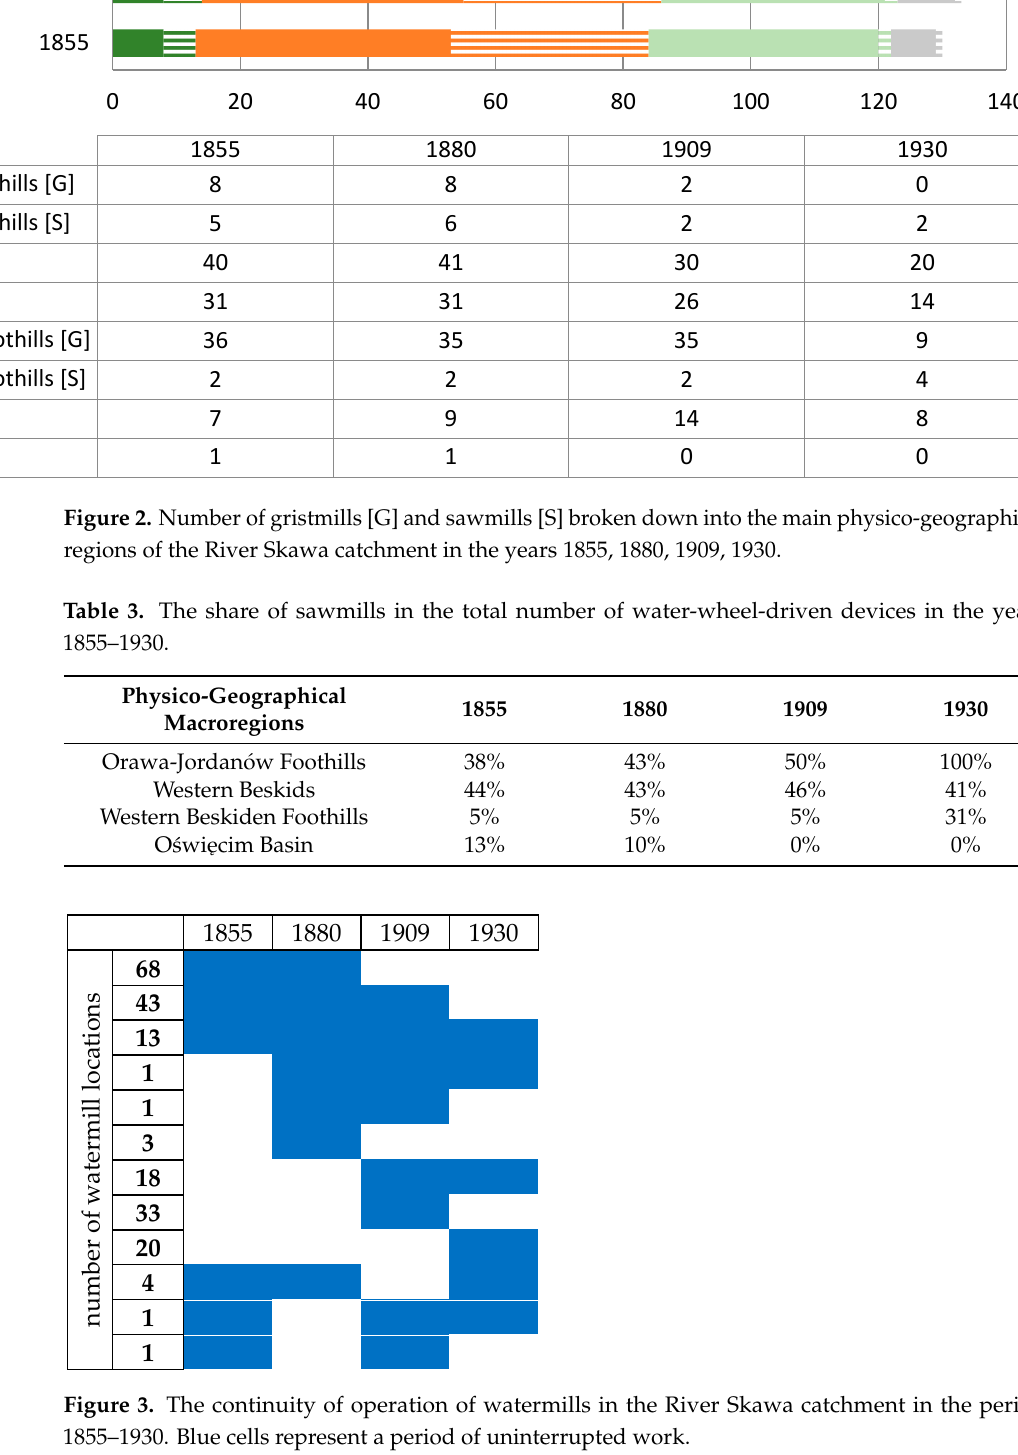
Figure 4. Water source for the watermills in the River Skawa catchment area, broken down into main physico-geographical regions. Only one watermill was located directly over the River Skawa channel in the entire period under study. However, seven weirs were built in the natural channel of the River Skawa, which directed part of the river’s flow to artificial millraces. Two of them were built in the Orawa-Jordanów Foothills, four in the Beskid Mountains, and one in the Western Beskidian Foothills. Millraces in the Beskid Mountains and in the Western Beskidian Foothills made it possible to use the waters of the River Skawa to drive wa- termills in the sections of the valley where the River Skawa channel was braiding or anabranching. In the entire analyzed period, the average power of a watermill decreased along with the downstream movement of the catchment area (Table 4). This is typical of mountain catchments where the potential energy of a watercourse decreases with the course of rivers. natural watercourse